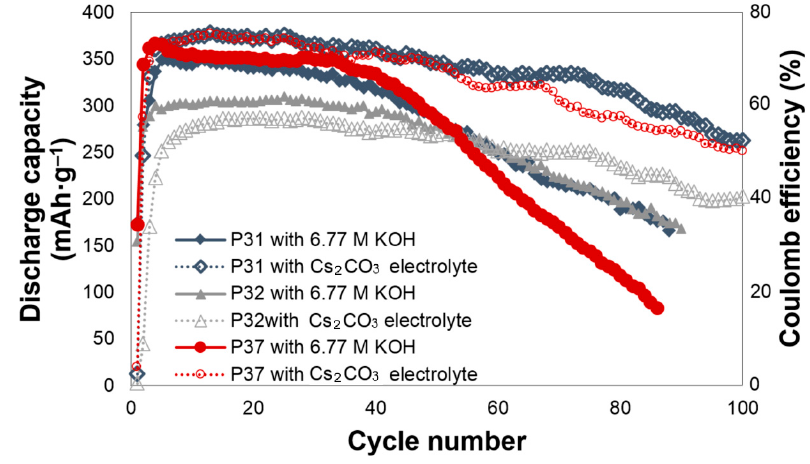
Figure 1. Discharge capacities of alloys P31, P32, and P37 in the 6.77 M KOH and 6.44 M KOH + 0.33 M Cs 2 CO 3